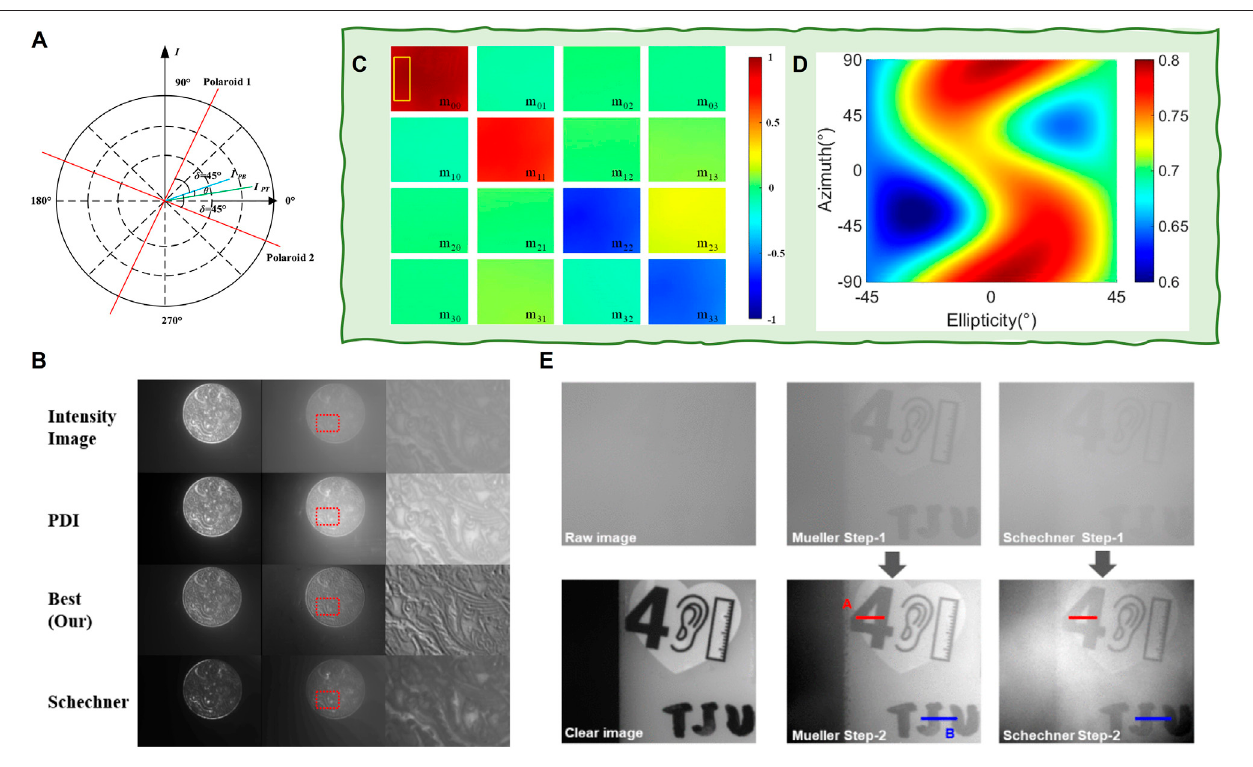
FIGURE 11 | (A) Principal diagram of polarization difference method based on MM. (B) Comparison results of scattering suppression by different methods and different scattering medium concentration, where Wang ’ s method is labeled by “ Best (Our) ” (reprint from Elsevier: Optics Communications [103], copyright 2021). (C) MM image of the scene in turbid water. (D) Variation of DoP with the azimuth and the ellipticity of PSG. (E) Underwater image restoration results and the histograms in different turbidities of water (reprint from IEEE: Photonics Journal [45], copyright